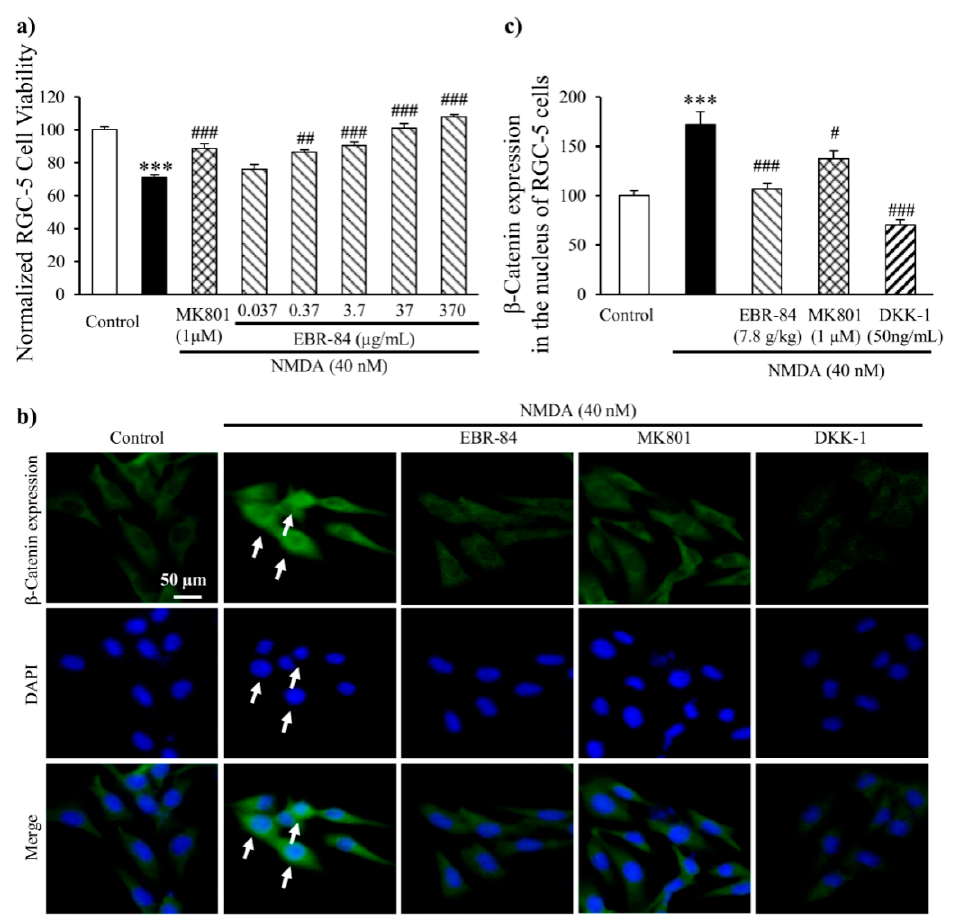
Figure 7. The effect of EBR-84 on cell viability and β -catenin expression of NMDA-treated RGC-5 cells. ( a ) The viability levels of RGC-5 cells in each group were normalized by that of the control group ( n = 6). *** p < 0.001 vs. the control group; ## p < 0.01 and ### p < 0.001 vs. the NMDA group. ( b ) Representative immunofluorescence staining images for β -catenin expression in the RGC-5 cells. The arrows denote the expression of β -catenin in the nuclei of RGC-5 cells. ( c ) Fluorescence intensity for β -catenin expression in the nuclei of RGC-5 cells. The fluorescence intensity of β -catenin in each group was normalized to that of the control group ( n = 6). *** p < 0.001 vs. the control group; # p < 0.05 and ### p < 0.001 vs. the NMDA group. The magnification of all figures is × 200. Scale bar is 50 µ m for all images.